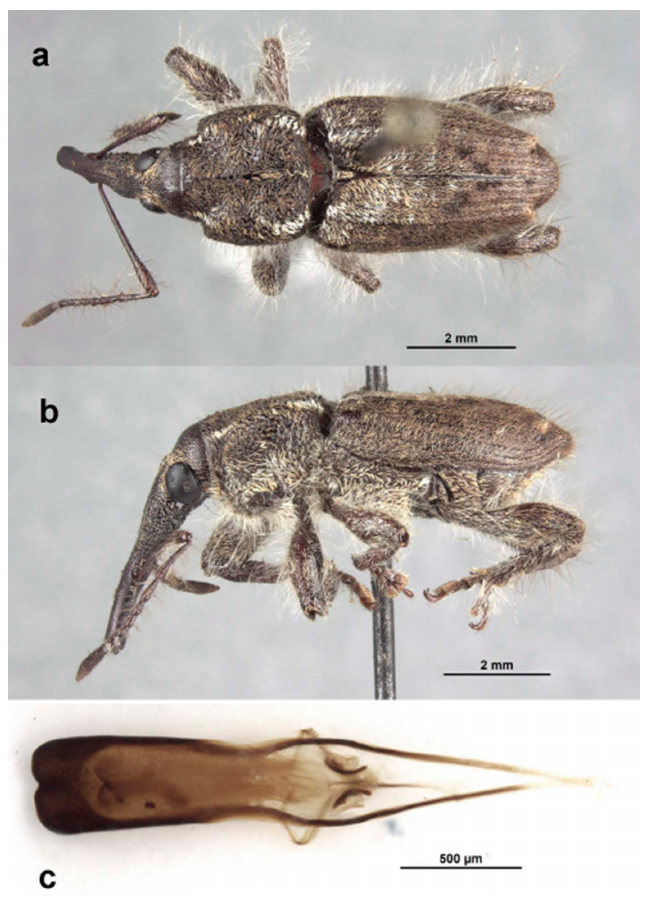
Figure 12 . Kuschelorhinus hirsutus : ( a ) habitus of male, dorsal aspect; ( b ) habitus of male, lateral aspect; ( c ) aedeagus, dorsal aspect. Diversity 2018 , 10 , x FOR PEER REVIEW